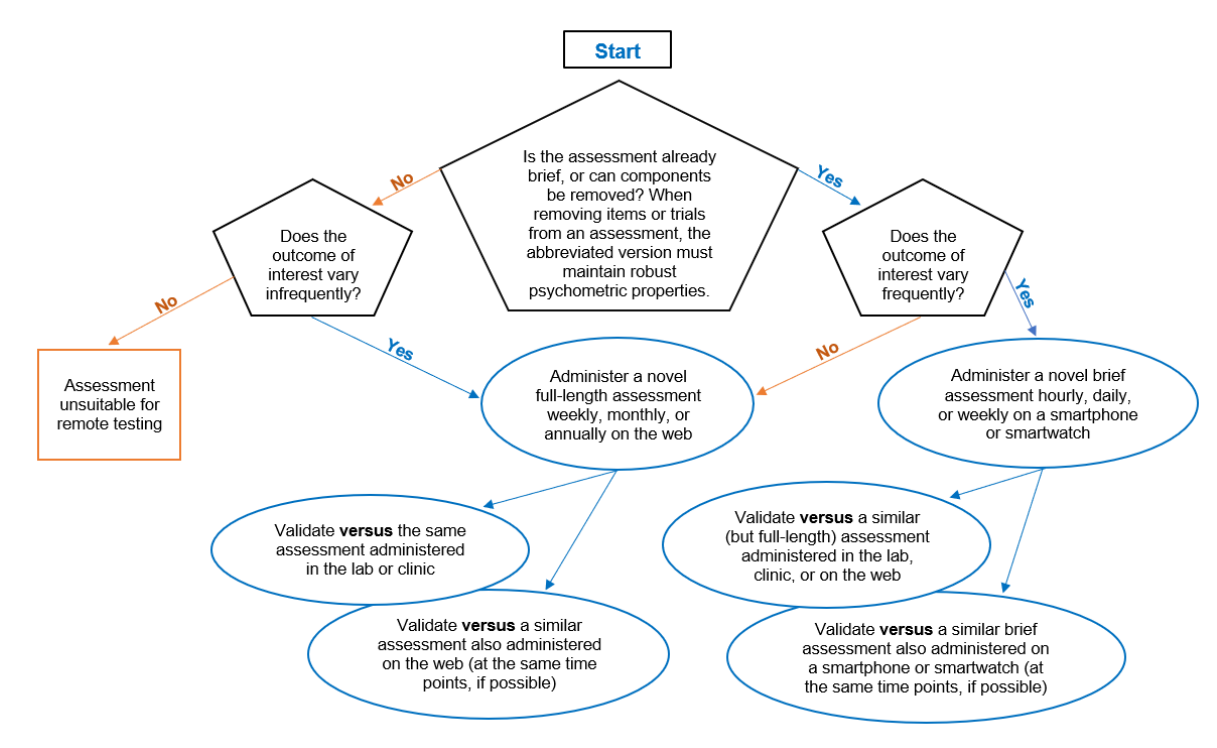
Figure 1. The decision process for validating digital assessments for remote